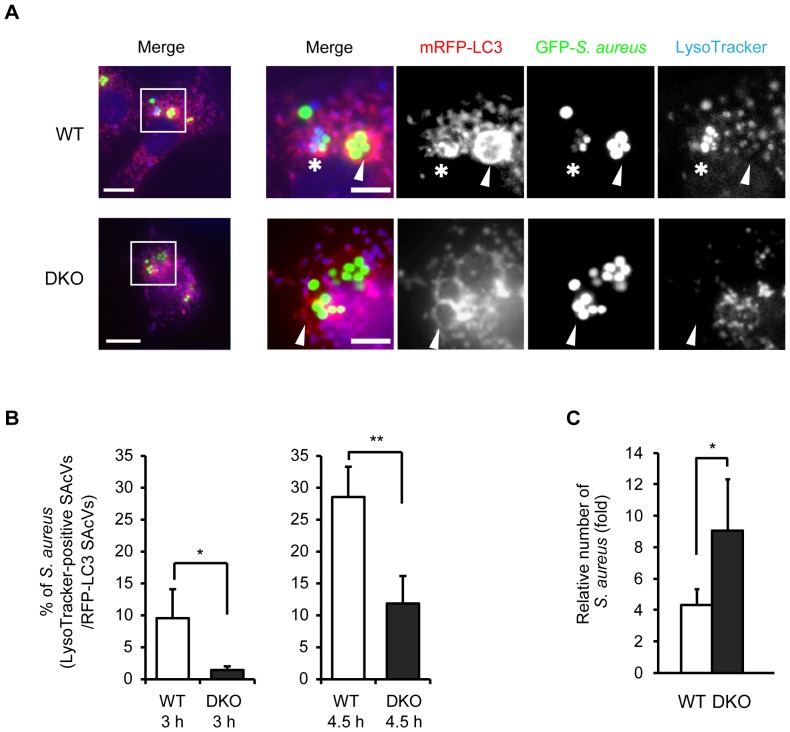
Decreased LysoTracker-positive vacuoles containing S. aureus in PRIP-DKO MEFs.(A) Co-localization of LC3-positive S. aureus-containing autophagosome-like vacuoles (SAcVs) and lysosomal marker (LysoTracker). PRIP-DKO (DKO) and wild-type (WT) MEFs transiently expressing mRFP-LC3 were infected with GFP-expressing S. aureus (ATCC 29213), after which extracellular bacteria were killed by lysostaphin treatment 1.5 h post-infection. The images were acquired using a fluorescent microscope. Scale bars: 20 µm (left) and 5 µm (right). Asterisks and arrowheads show LC3-positive SAcVs staining with and without LysoTracker, respectively. (B) Comparison of the number of S. aureus in LysoTracker-positive vacuoles vs. the number of S. aureus in mRFP-LC3-positive signals from three independent experiments. WT, 9.6±4.5% (3 h, n = 25) and 28.6±4.7% (4.5 h, n = 28); DKO, 1.4±0.6% (3 h, n = 26) and 11.9±4.3% (4.5 h, n = 25). (C) Colony count assay. Homogenates of S. aureus-infected MEFs prepared 1.5 or 3 h post-infection were plated on tryptic soy agar and colony numbers were counted after 16 h incubation at 37°C. Graph represents relative number of colonies (the number of colonies at 3 h vs. the number of colonies at 1.5 h). Data represent the means ±SEM (n = 3; WT, 4.3±1.3%; DKO, 9.0±3.3%). *p<0.05, **p<0.01.